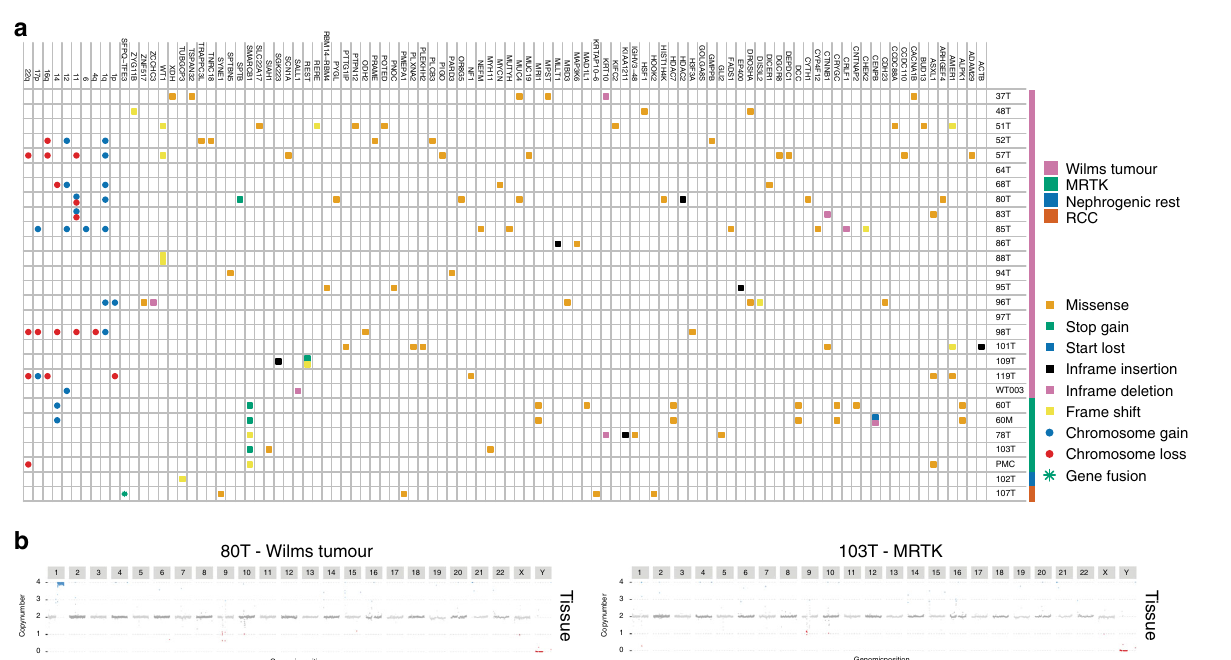
Fig. 3 Cellular heterogeneity within Wilms tumour organoid cultures. a t-SNE representation of single cells from four Wilms tumour organoid lines (51T, 80T, 88T and 101T). Cells are coloured by organoid of origin (top panel) or clustering (bottom panel). Indicated are the cell types the populations are representing based on marker gene expression (see panel b ). e: epithelial, s: stromal, b: blastemal-like. b t-SNE maps showing the colour-coded logged expression levels of several markers for each population demonstrating that different cell types are present in 51T and 88T, whereas 80T and 101T organoids primarily consist of different epithelial subpopulations, which is in line with their histological appearance. c High-resolution 3D imaging of 51T Wilms tumour organoids immunolabeled for E-cadherin (E-cad; red), SIX2 (green) and CD90 (white). Bottom panels depict enlargement from top panel in 3D (left panel) and a representative optical section (others panels). Scale bars, 100 µ m (top) and 50 µ m (bottom). Images are representative of n = 2 independent experiments. d Immuno fl uorescence imaging on 51T Wilms tumour tissue sections immunolabeled for E-cadherin (E-cad; red), SIX2 (green) and CD90 (white). Scale bars 100 µ m. Images are representative of n = 2 independent experiments.